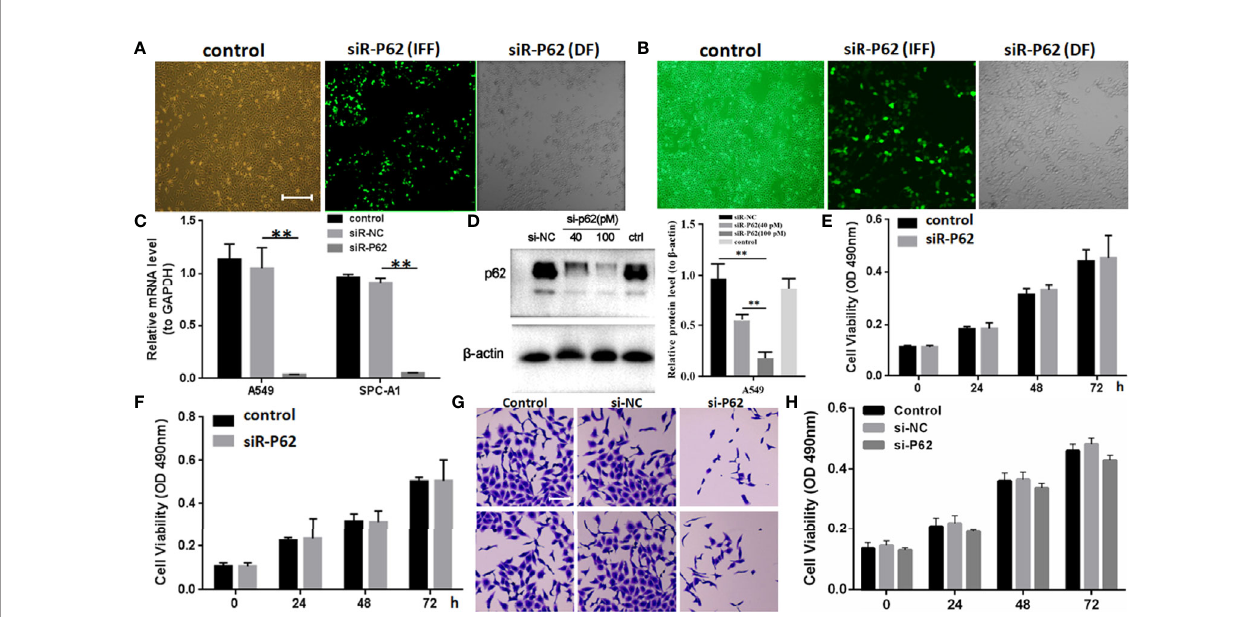
FIGURE 3 | p62 downregulation using small interfering RNA transfection did not inhibit tumor proliferation in SPC-A-1 and A549 cells. (A) Small interfering p62 RNA (siR-p62) plasmid was successfully transfected in A549 cells. The left control indicates untreated tumor cells. The middle siR-p62 (IFF) indicates small interfering p62 RNA-transfected tumor cells in immuno fl uorescence fi eld. The right siR-p62 (DF) indicates small interfering p62 RNA-transfected tumor cells in dark fi eld (scale bar 200µm). (B) siR-p62 plasmid was successfully transfected in SPC-A-1 cells. (C) After 48h p62 mRNA expression level was downregulated in siR-p62 transfected cells than scrambled control cells (siR-NC). (D) p62 protein expression level was downregulated in siR-p62 transfected cells than scrambled control cells (siR-NC). (E, F) The difference in proliferation between siR-p62 transfected group and scrambled control group (siR-NC) of A549 (E) and SPC-A-1 (F) cells was found to be not signi fi cant between 0 h to 72 h. (G, H) Cell colony formation assay showed the difference in proliferation between siR-p62 transfected group and scrambled control group (siR-NC) of A549 cells was not signi fi cant between 0 h to 72 h (scale bar 50µm). control, untreated A549 or SPC-A-1 cells; siR-p62, small interfering p62 RNA transfected cells; siR-NC, siR-p62 scrambled control; IFF, immuno fl uorescence fi eld; DF, dark fi eld; **P < 0.01 .